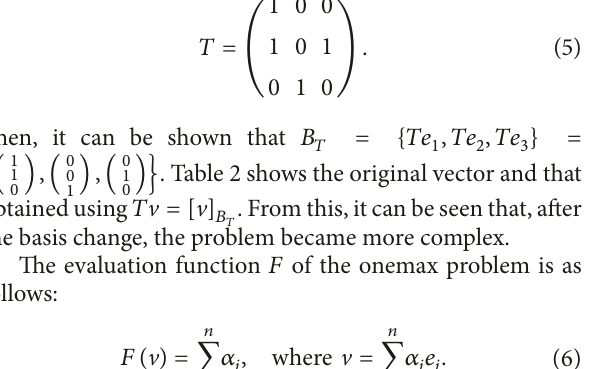
value. In contrast, when the genes are independent, the value is zero.